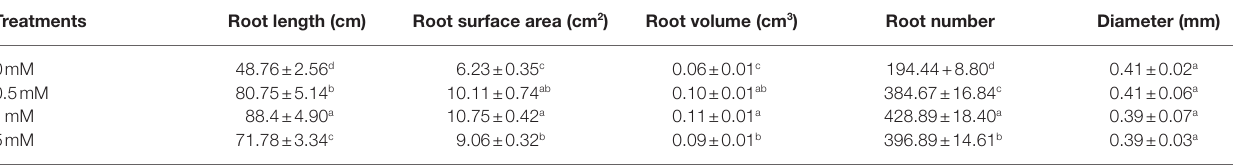
FIGURE 1 | The effect of P treatments on phenotypic symptoms and root growth. Leaf color and expansion rate (A–D) , and root growth (E–H) of Pyrus betulifolia seedlings exposed to 0.0 (A,E) , 0.5 (B,F) , 1.0 (C,G) , or 5 mM P (D,H) . The bars in (A–H) are 1 cm. TABLE 1 | Effects of different P treatments on roots morphologic parameters of the pear seedling rootstock.